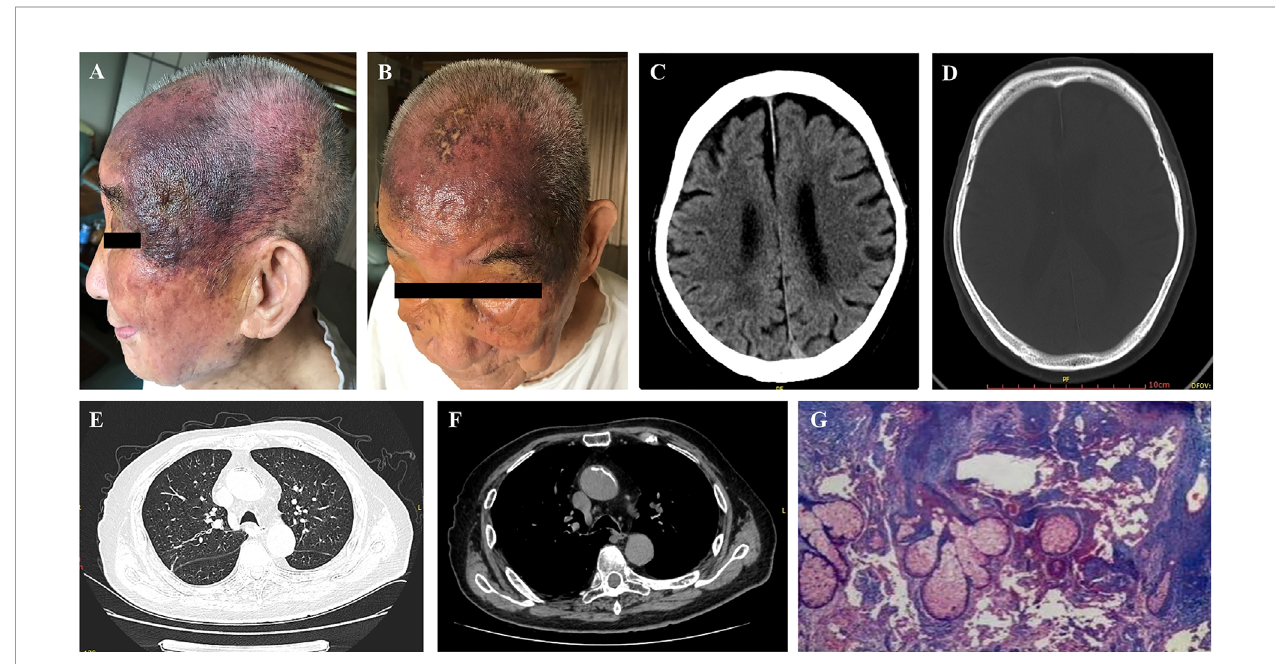
FIGURE 1 | Examination before treatment including dermatological inspection (A, B) , head CT (C, D) , chest CT (E, F) and pathological assessment (G)